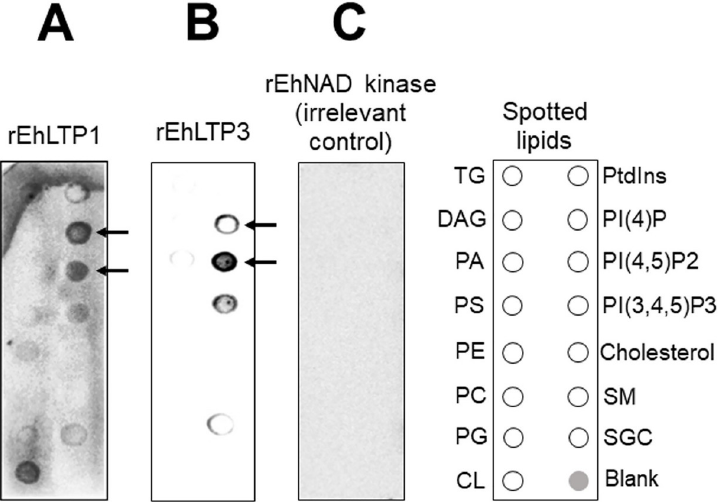
Fig 1. Binding of recombinant EhLTP (rEhLTP) to lipids by protein lipid overlay assay. (A) Membrane Lipid Strips ™ were incubated overnight at 4˚C with 1 mg/ml of rEhLTP1. (B) Membrane Lipid Strips ™ were incubated overnight at 4˚C with 1 mg/ml of rEhLTP3. Binding of protein to the lipid spots was detected by subsequent incubation with anti-His mouse monoclonal antibody and secondary anti-mouse peroxidase antibody as described in Methods. The lipids spotted on the strips are: Glyceryl tripalmitate or Triglyceride (GT), Diacylglycerol (DAG), Phosphatidic Acid (PA), Phosphatidylserine (PS), Phosphatidylethanolamine (PE), Phosphatidylcholine (PC), Phosphatidylglycerol (PG), Cardiolipin (CL), Phosphatidylinositol (PI), phosphatidylinositol 4-phosphate (PtdIns4P), phosphatidylinositol 4,5-bisphosphate [PtdIns(4,5)P 2 ], phosphatidylinositol 3,4,5-trisphosphate [PtdIns(3,4,5)P 3 )], Cholesterol, Sphingomyelin (SM), 3-sulfogalactosylceramide or Sulfatide (SGC), and Blank. C Negative control, the same treatment as “ A ” or “ B ”, the only exception was in place of study proteins (rEhLTP3 or rEhLTP1), we used rEhNAD kinase, which has no reported lipid binding